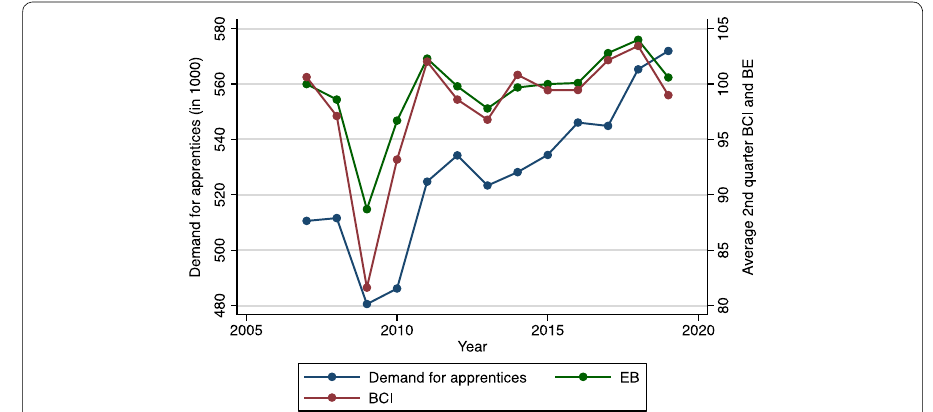
Fig. 2 Demand for apprentices, ifo Business Climate Index (BCI), and ifo Employment Barometer (EB; 2007– 2019). Source: ifo Business Climate Index (ifo Geschäftsklimaindex , https ://www.ifo.de/en/surve y/ifo-busin ess-clima te-index ), and ifo Employment Barometer ( ifo Beschäftigungsbarometer, https ://www.ifo.de/en/surve y/ifo-emplo yment -barom eter); Federal Employment Agency (statistics on the apprenticeship market)